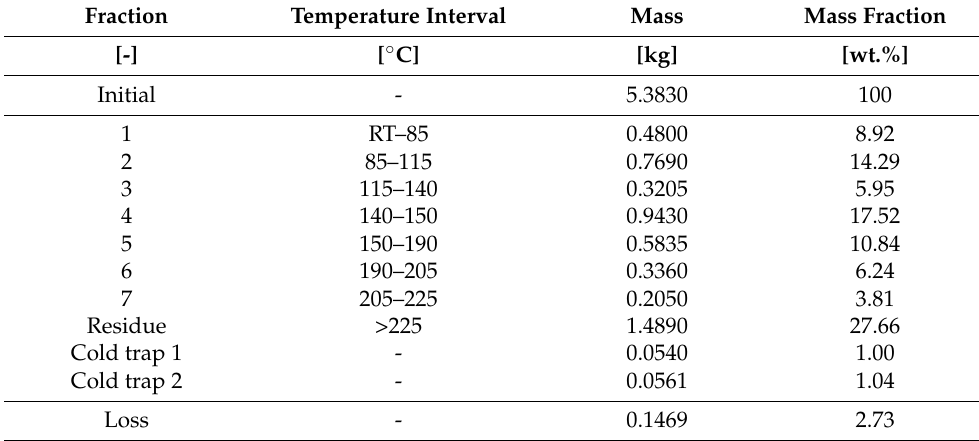
Table 4. Distillate fractions with temperature intervals and mass